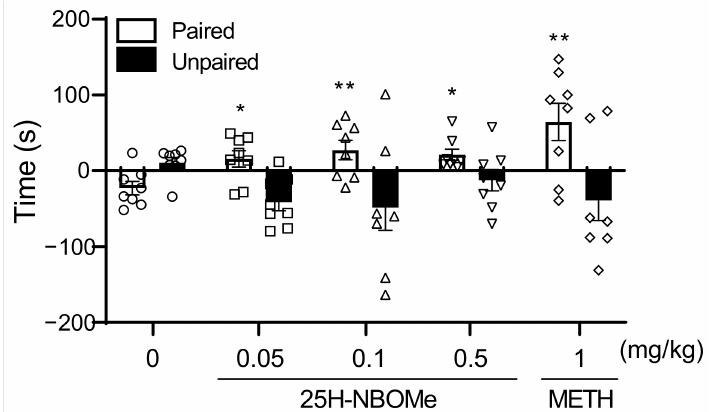
Figure 3. Effect of 25H-NBOMe administration on the place conditioning paradigm in mice. Time difference spent in the drug-paired (white bar) and drug-unpaired (black bar) compartment between the drug administration group and the vehicle (saline) group during pre-conditioning and post- conditioning (0: circles, 25H-NBOMe 0.05 mg/kg: squares, 25H-NBOMe 0.1 mg/kg: triangles, 25H-NBOMe 0.5 mg/kg: down triangles, METH 1 mg/kg: diamonds). Data are expressed as mean ± SEM ( n = 8 each group). * p < 0.05; ** p < 0.01 vs. vehicle, determined by a two-way ANOVA followed by Bonferroni’s post-hoc